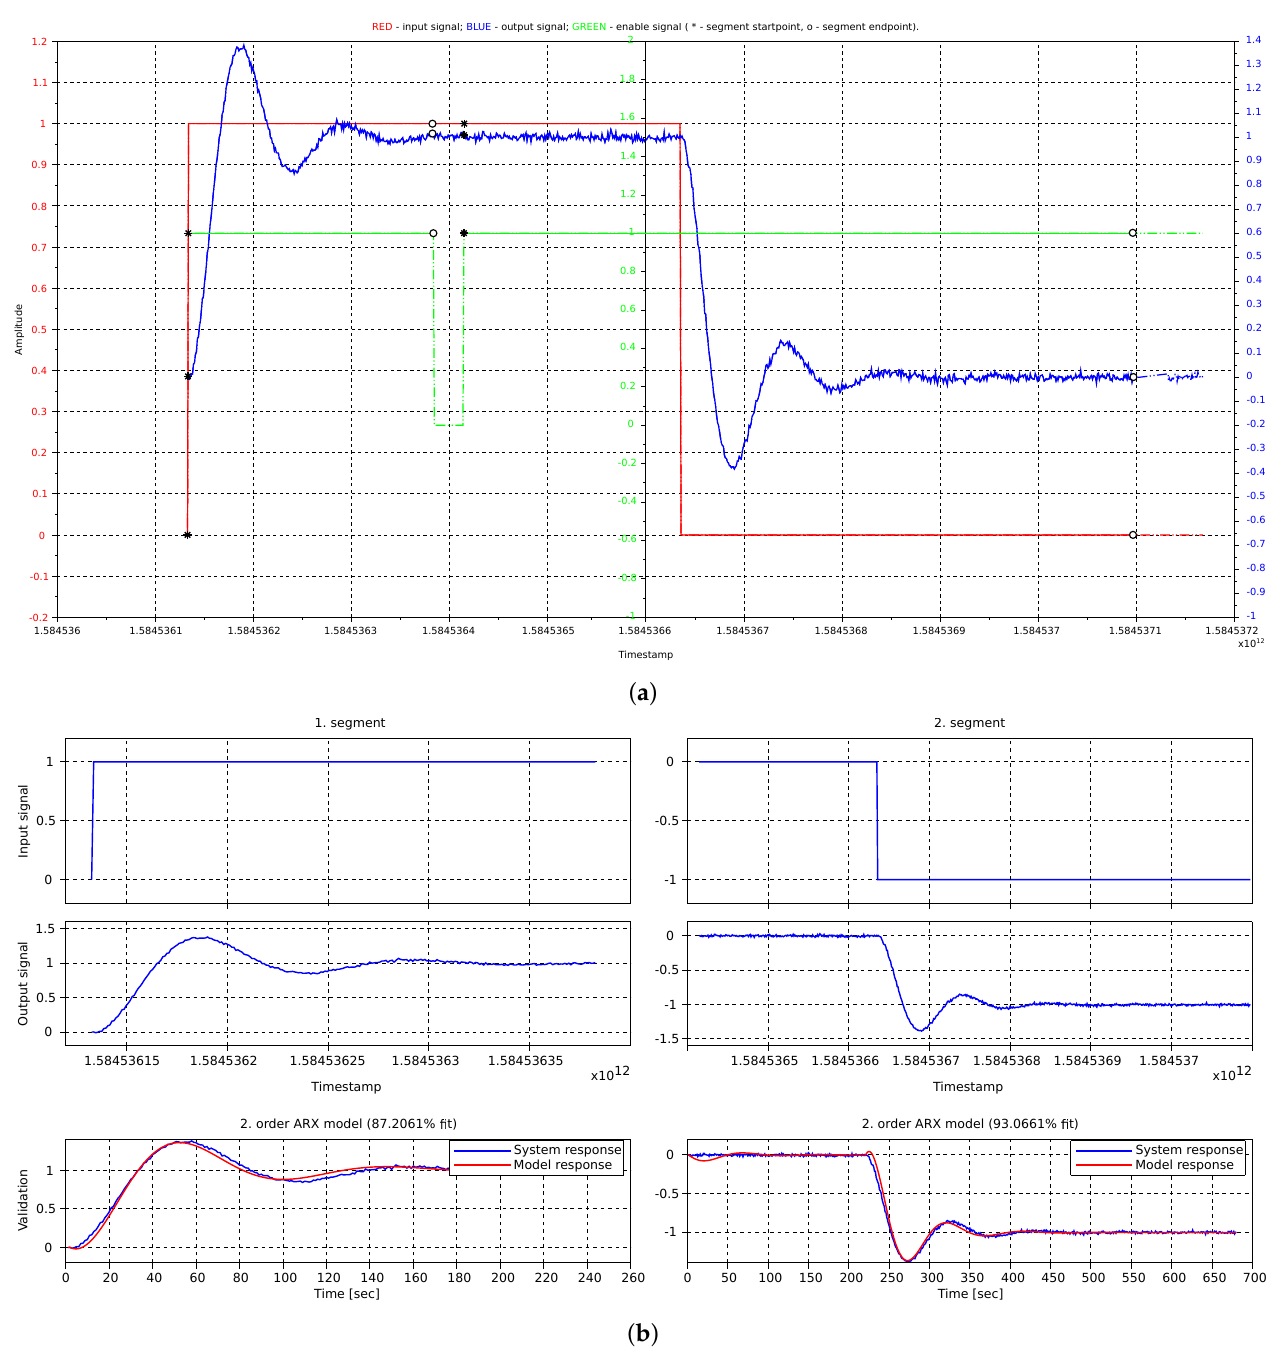
Figure 3. Graphical output obtained from off-line simulation. ( a ) Input, output and enable/disable sig- nals, and their segmentation. ( b ) Input and output data used for identification and model